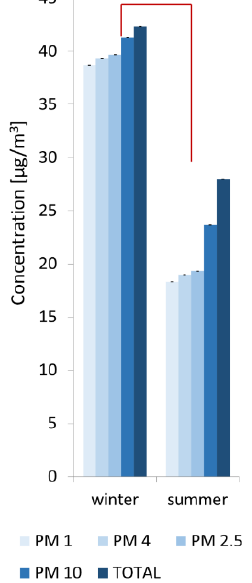
Figure 4. Particulate matter (PM) concentrations in the air in summer and winter in the gardens surrounding the Northern Pergola at the Museum of King John III’s Palace at Wilanow. The PM abbreviation means particulate matter with an aerodynamic diameter grain size expressed in µm. The data represent averages with standard deviation. * -Indicates significant differences according to the Student’s t -test ( p ≤ 0.05) when comparing PM concentrations between winter and summer. The results were consistent with the data from the measuring station located in